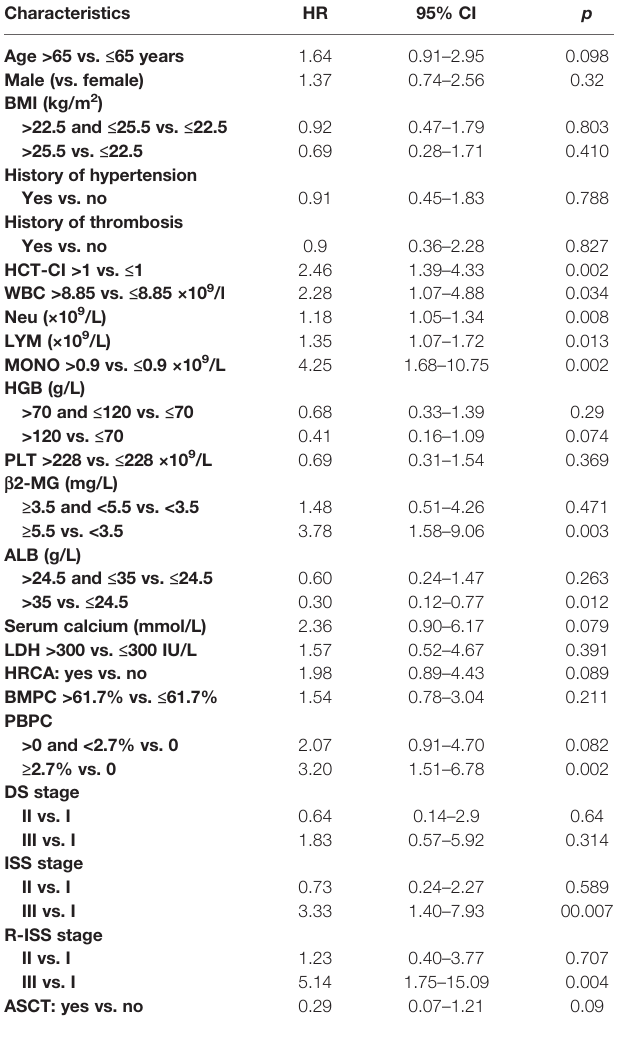
TABLE 1 | Univariate Cox regression analyses in the development cohort.